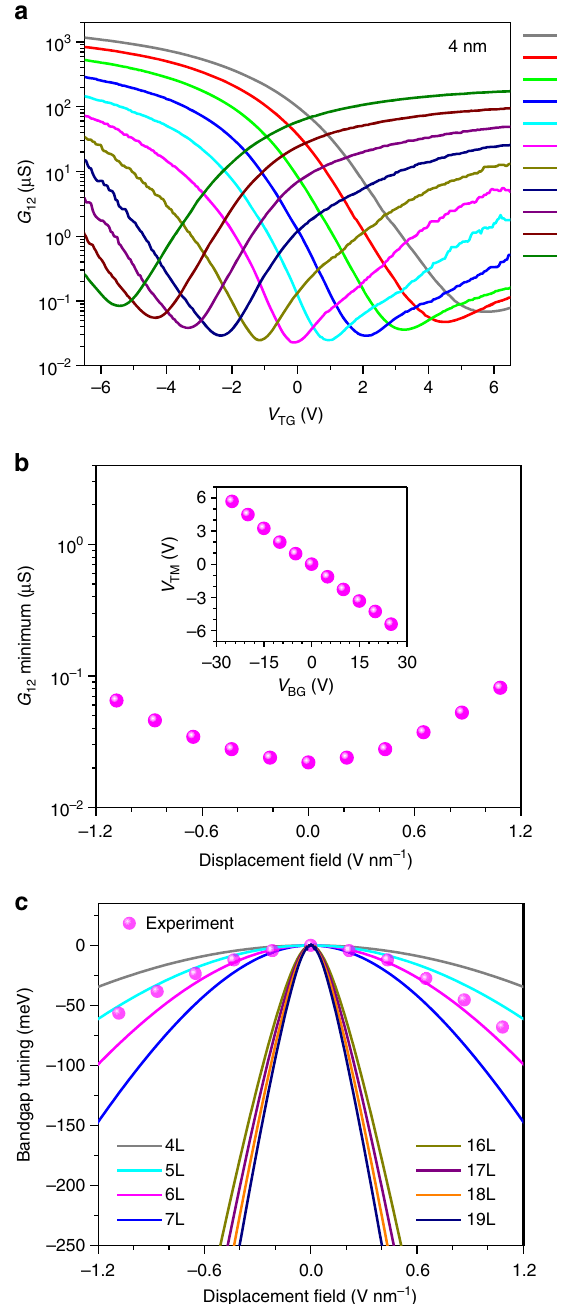
Figure 2 | Bandgap tuning in a 4nm-thick BP film. ( a ) The 4nm-thick BP film conductance as a function of top gate bias ( V TG ) at different static back gate biases ( V BG ) from (cid:2) 25 to 25V. ( b ) The minimum conductance at the charge-neutrality point as a function of external displacement field. Inset: the top gate bias at which the minimum conductance occurs ( V TM ) as a function of the back gate bias ( V BG ). The linear relation indicates the effective doping compensation by the back and top biases, leading to an insulating state at the charge-neutrality. ( c ) Solid lines: The calculated bandgap tuning properties for BP films consisting of 4, 5, 6, 7, 16, 17, 18 and 19 layers using a tight-binding model built on the DFT. The BP films with different thicknesses exhibit distinctively different tuning properties. Purple dots: the measured bandgap tuning results for the 4nm-thick BP film ( B 7